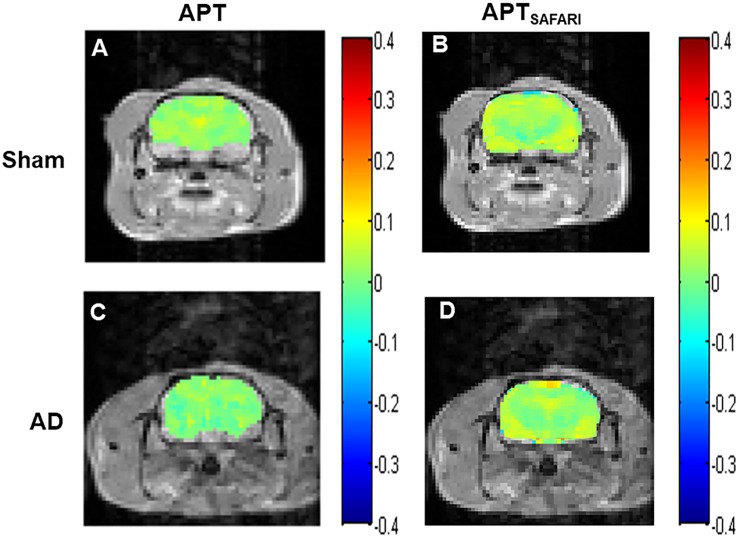
(A) APT imaging of sham operated control, (B) APTSAFARI imaging of sham operated control, (C) APT imaging of AD model, (D) APTSAFARI imaging of AD model.